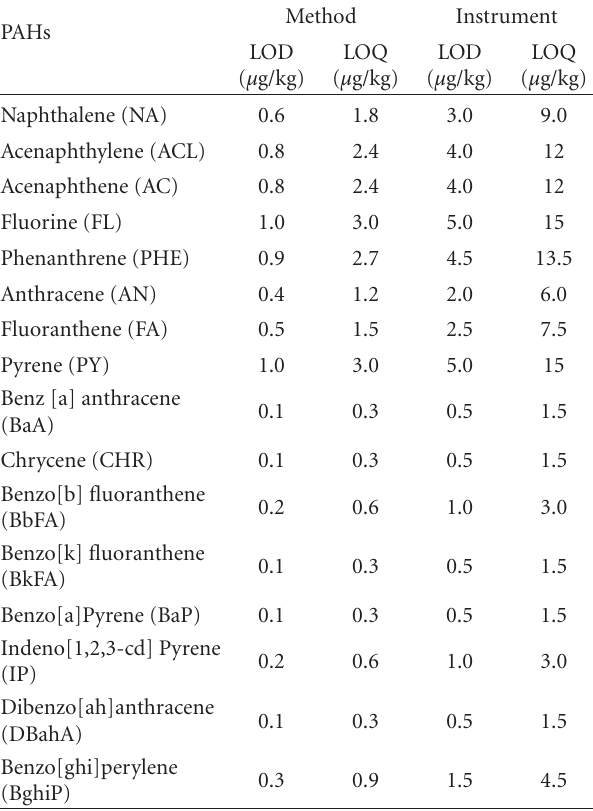
Table 3: Validation of the analysis of the 16 PAHs applying the recommended method.